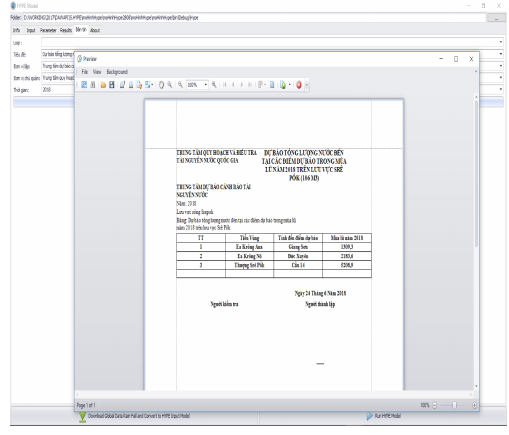
Fig. 12: The interface of the water resources warning bulletin extracted from V-HYPE.